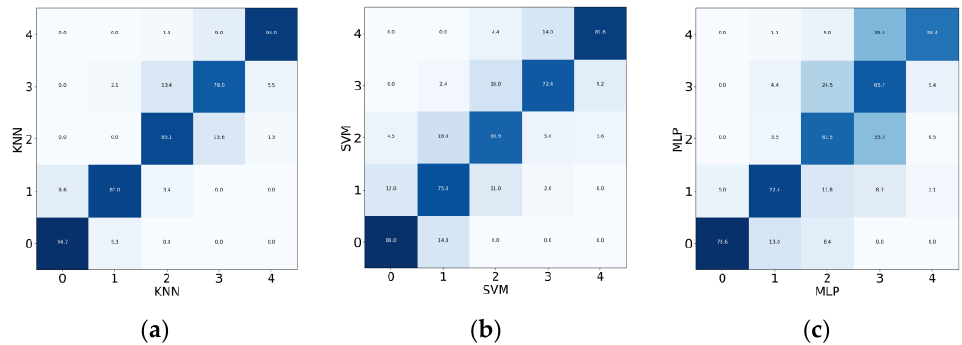
Figure 12. Three algorithms confusion matrix: ( a ) KNN confusion matrix; ( b ) SVM confusion matrix; ( c ) MLP confusion matrix. Here, 0, 1, 2, and 3 represent membership accuracy, and 4 represents positioning accuracy.